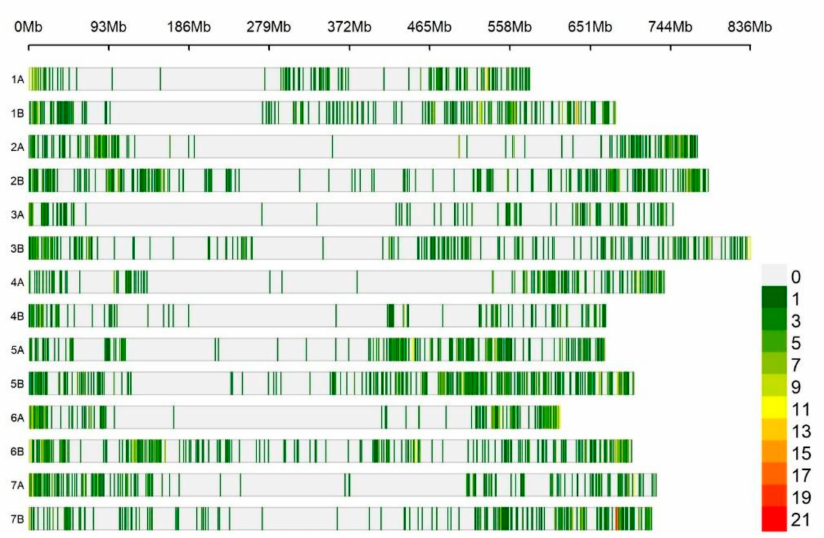
Figure 2. Distribution of the 4624 high-quality SNP markers within 1 Mb windows for the 14 chro- mosomes of the durum wheat